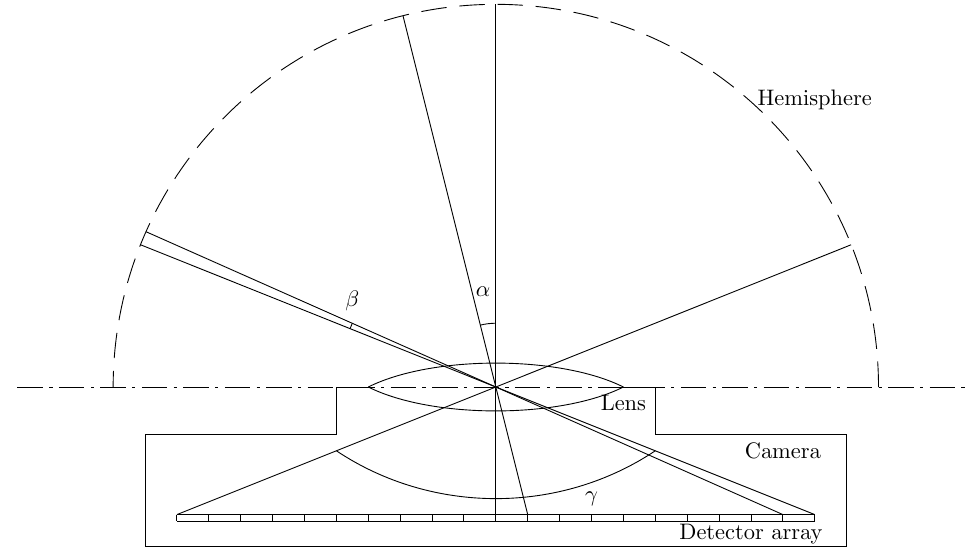
Figure 4. The angles mapped to the detector cells are not constant.